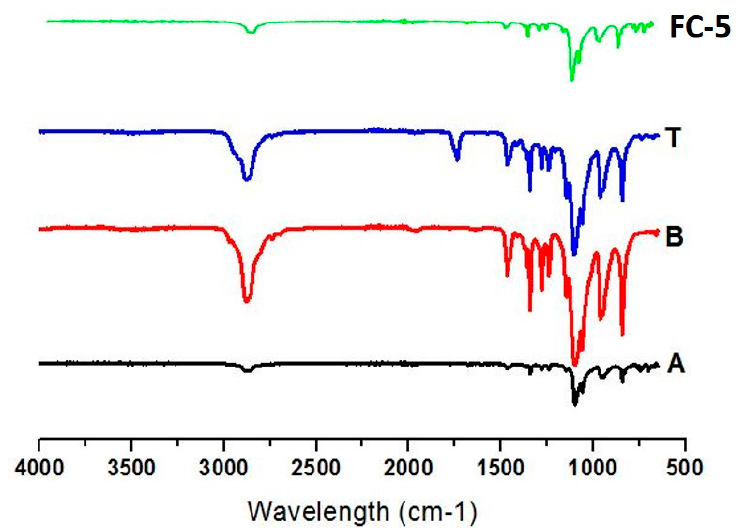
Figure 4. FTIR spectra of (A) pure EBT, (B) poloxamer-188, (T) TPGS1000, and (FC-5) micelles- loaded film.